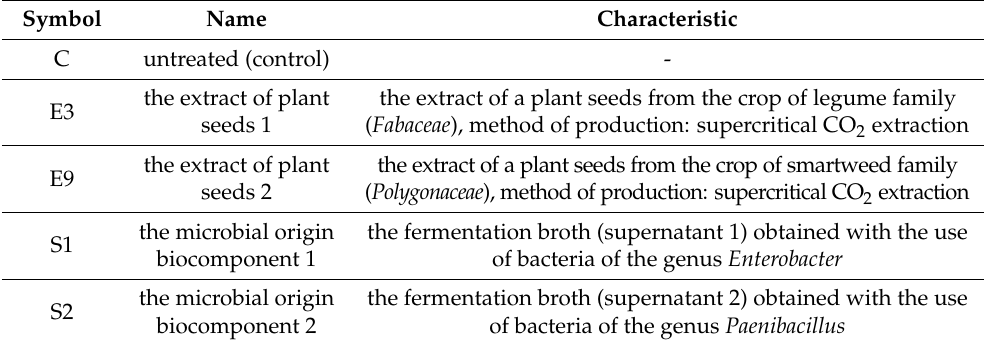
Table 1. Characteristics of the preparations used in the